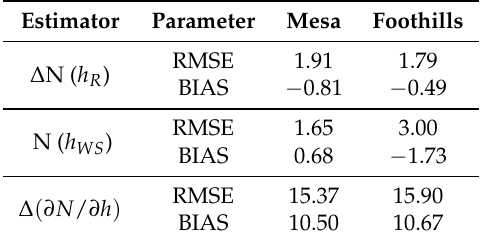
Table 4. RMSE and BIAS of mean refractivity variation estimates and refractivity vertical gradient variations at the radar height and at the Mesa and Foothills locations.